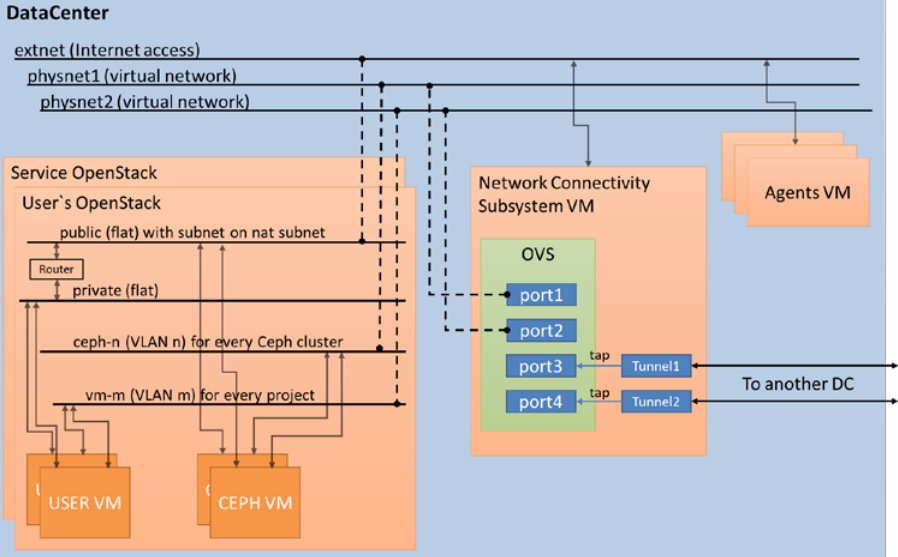
Fig. 5. DC OpenStack instances, Ceph, agents